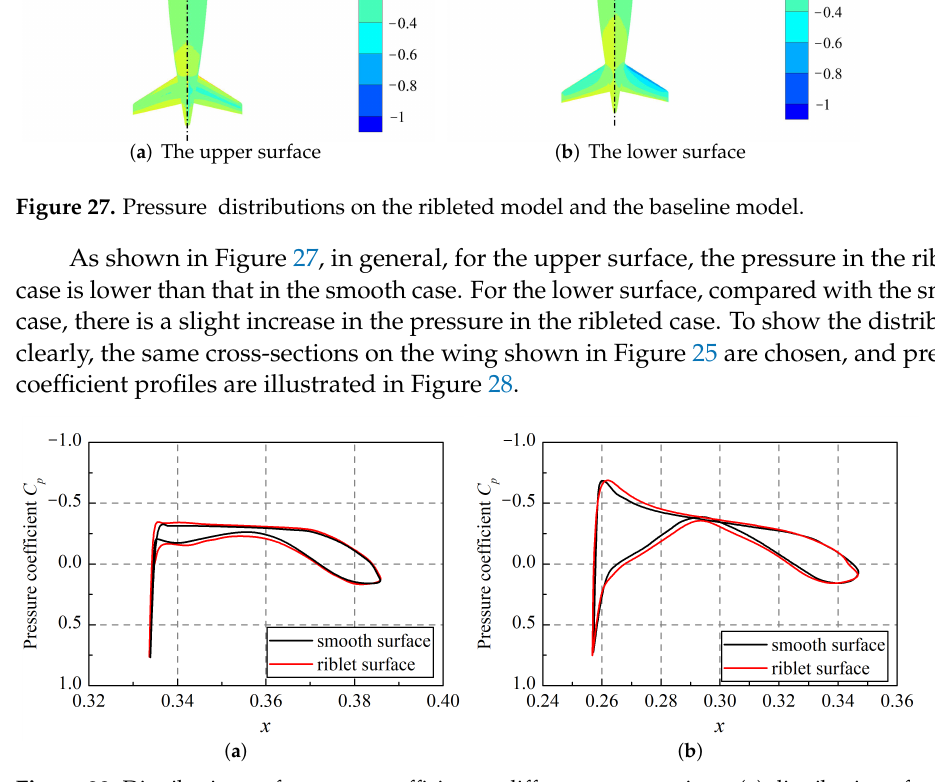
Figure 28. Distributions of pressure coefficient at different cross-sections. ( a ) distribution of pressure coefficient at cross-section A; ( b ) distribution of pressure coefficient at cross-section